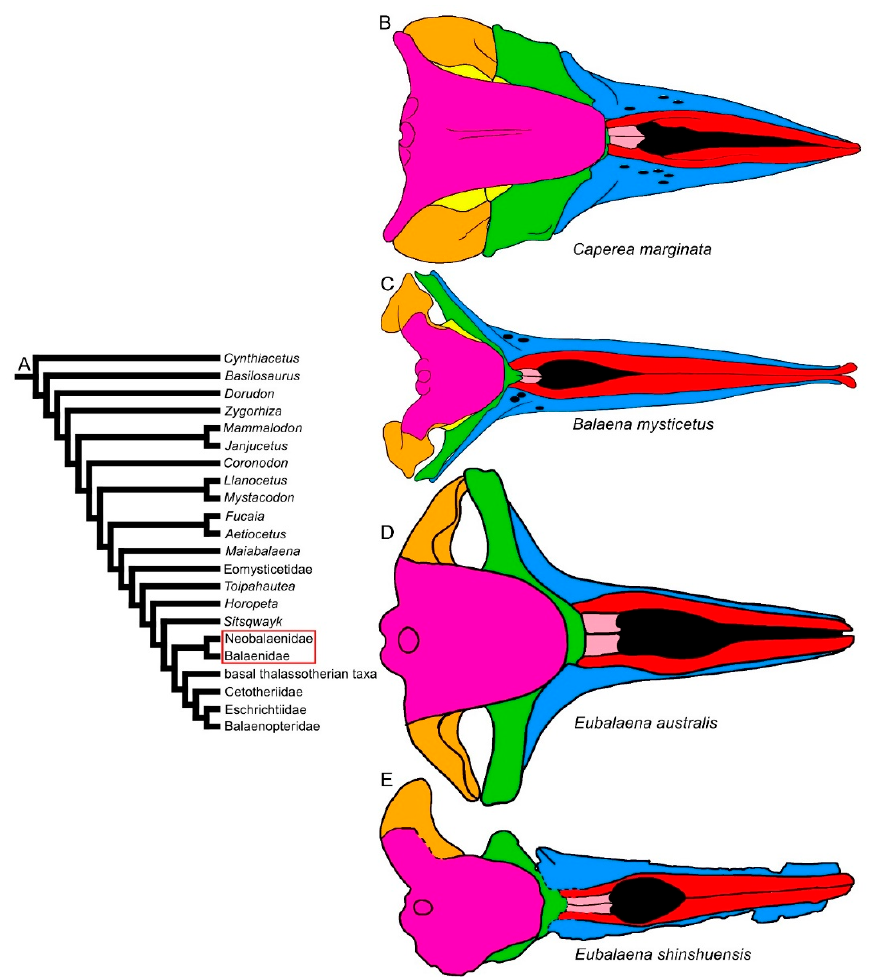
Figure 11. Diversity of balaenomorph mysticete skulls in dorsal view: Balaenoidea. ( A ) Phylogenetic relationships among mysticetes showing the branching order of Balaenoidea. ( B ) Skull of Caperea marginata . ( C ) Skull of Balaena mysticetus . ( D ) Skull of Eubalaena australis . ( E ) Skull of Eubalaena shinshuensis . Not to scale. The skulls are represented as if they shared the same condylobasal length.